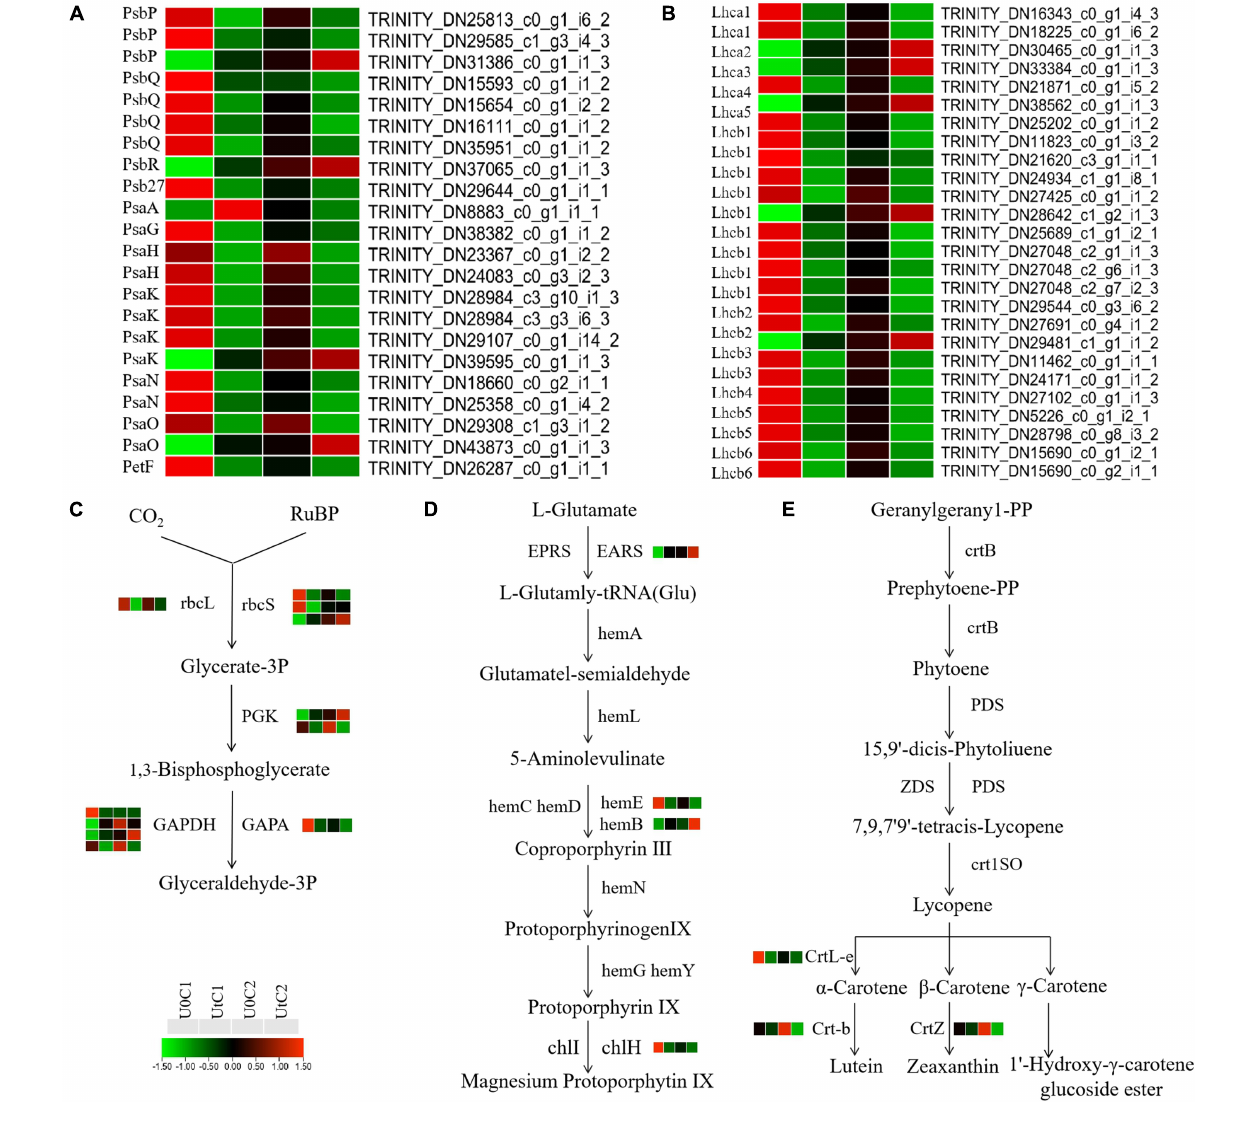
FIGURE 9 | Heat maps of differentially expressed genes (DEGs) in Mingui 1 and Mingui 2 leaves. (A) Photosynthesis, (B) photosynthetic-antenna protein, (C) carbon fixation, (D) chlorophyll metabolism, (E) carotenoid biosynthesis. Heat maps were drawn using log2-transformed FPKM